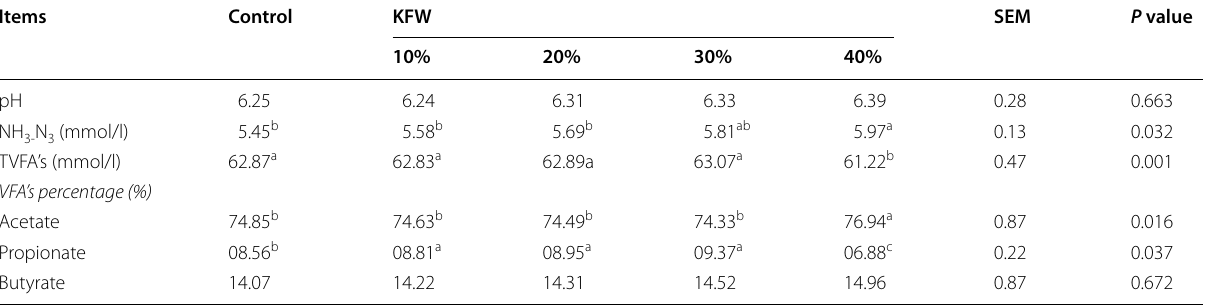
a,b,c Mean in the same row bearing different superscripts are significantly different